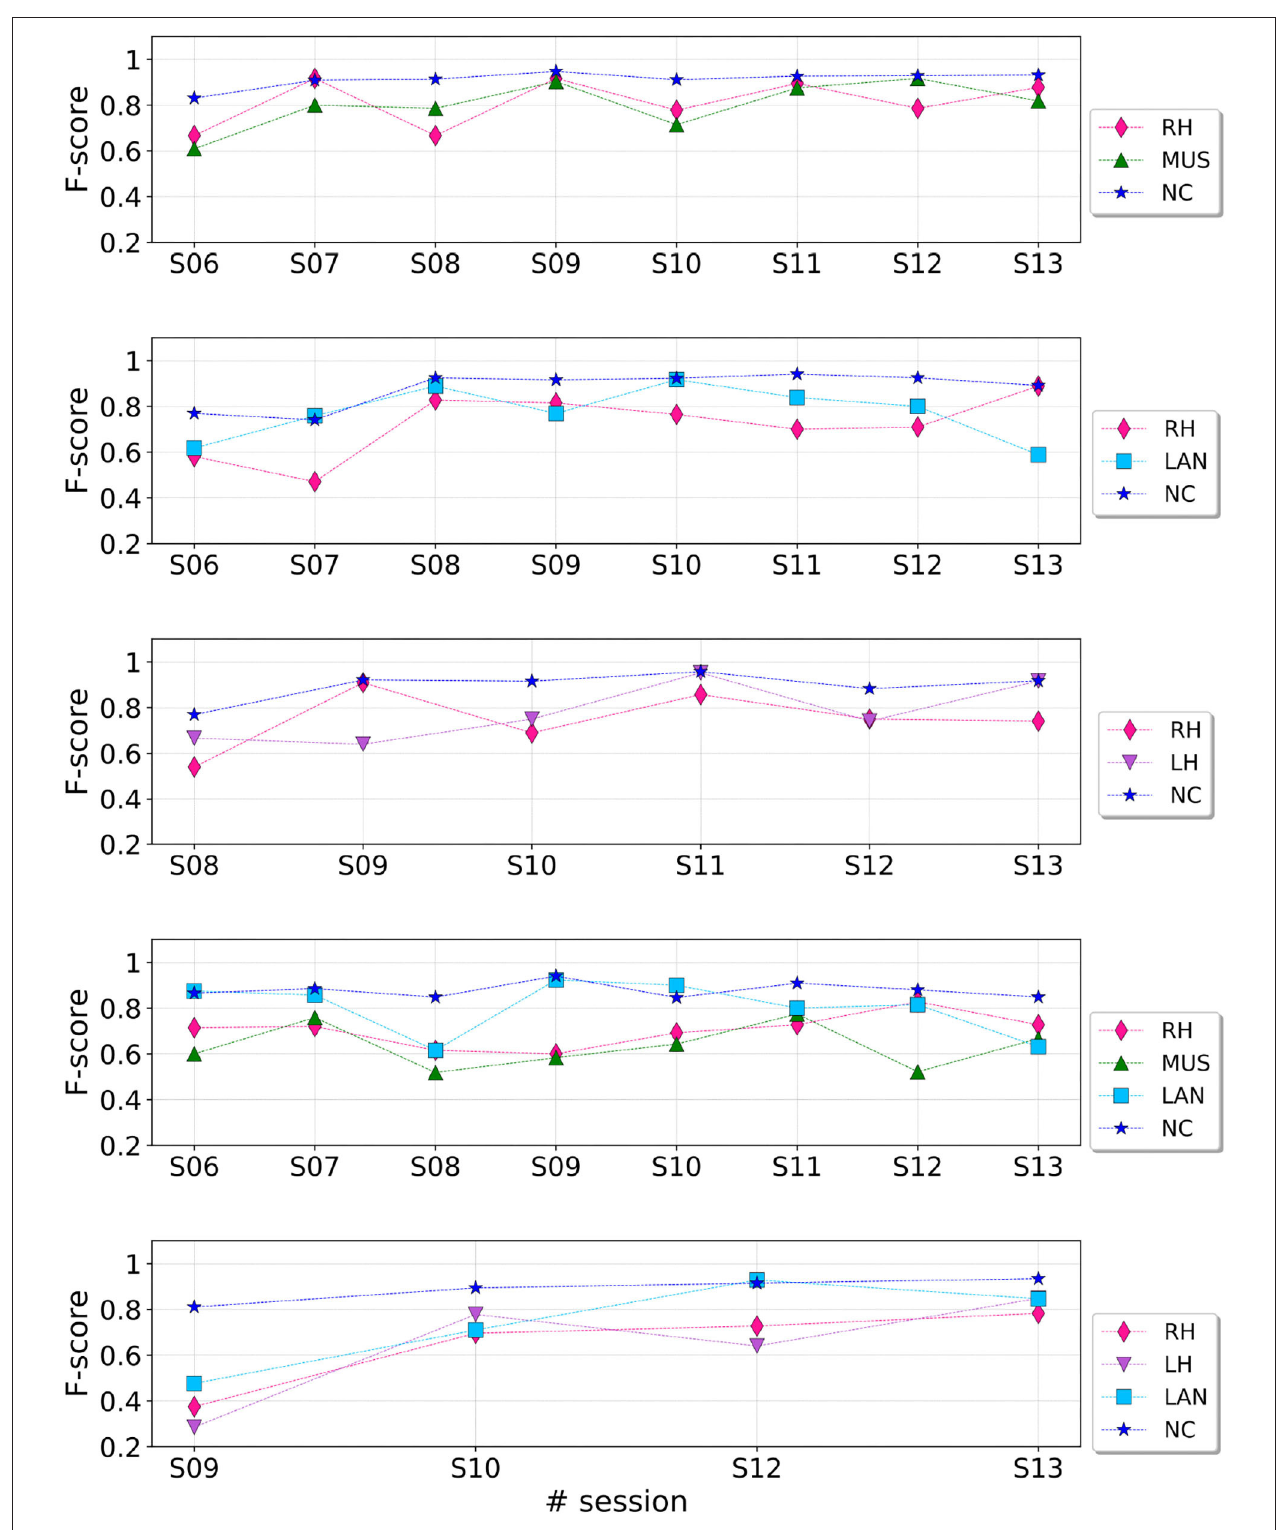
FIGURE 5 | F-score values reached by each training paradigm across sessions.